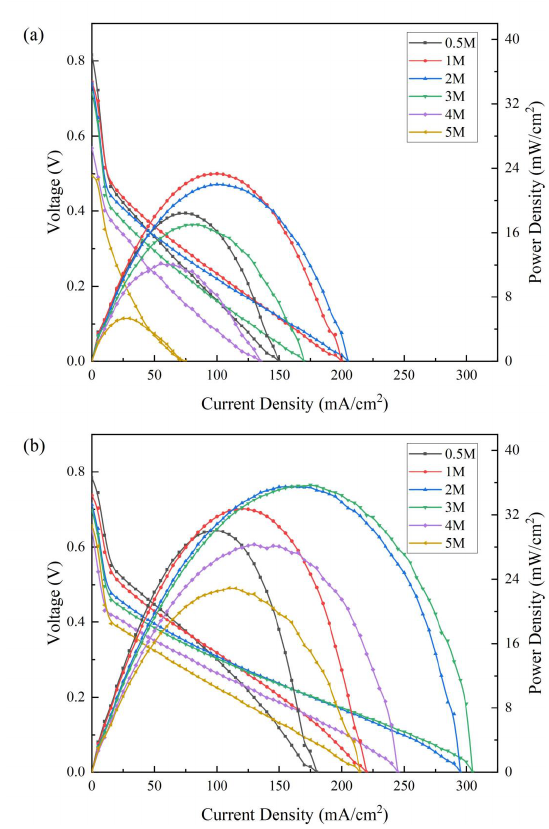
Figure 5. Polarization curves at different methanol concentrations at 343 K: ( a ) CP- µ DMFC; ( b ) rGO/CP- µ DMFC. Table 1. Maximum power density and open-circuit voltage of the CP- µ DMFC and the rGO/CP- µ DMFC at different methanol